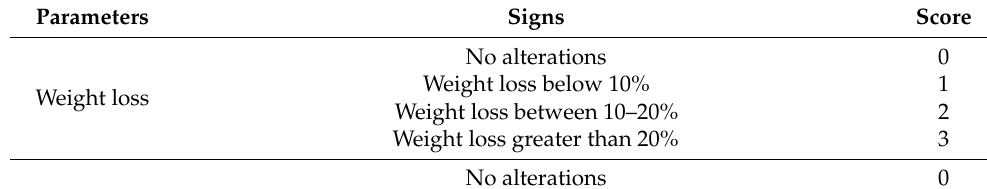
Table 1. Parameters evaluated in the safety trial.